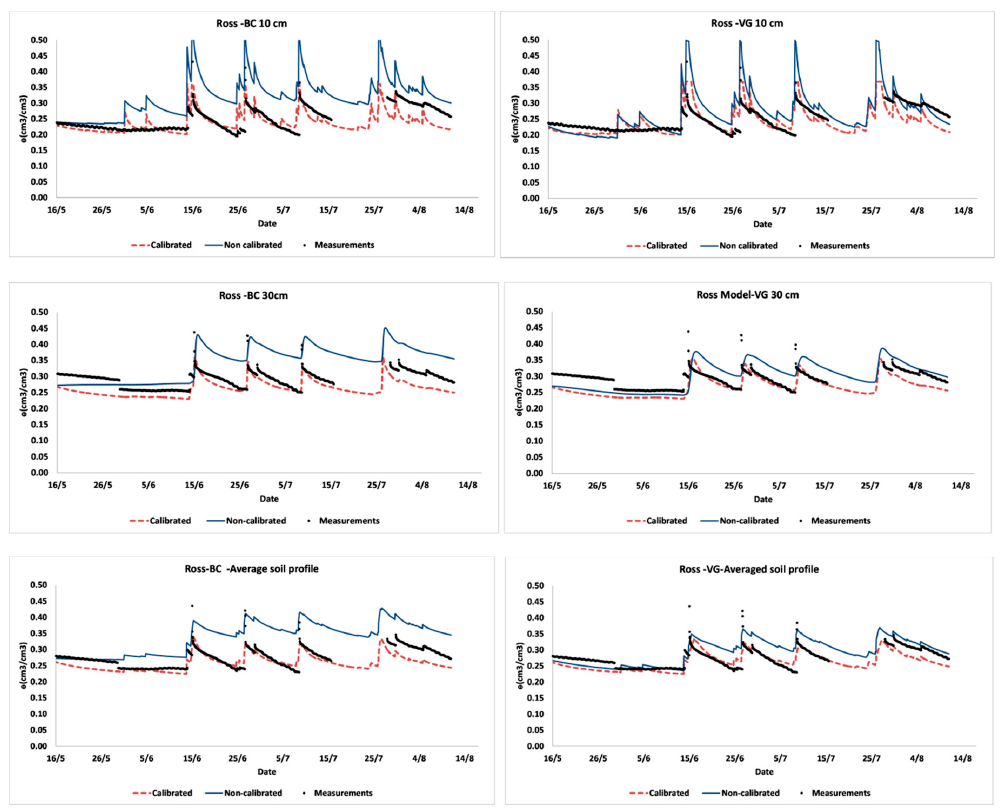
Figure 5. Results of validation of Ross–Brooks and Corey and Ross–Van Genuchten.